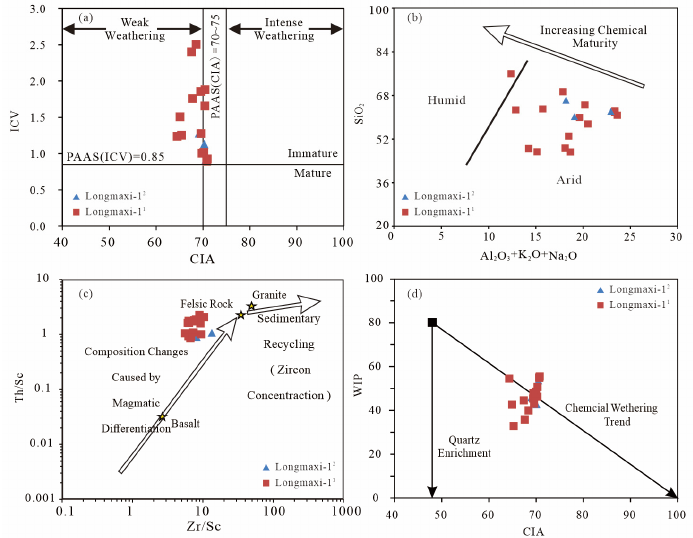
Figure 5. The discrimination diagram of palaeoweathering intensity and maturity in Longmaxi-1 black shales. ( a ) CIA-ICV [45]; ( b ) (Al 2 O 3 +K 2 O+Na 2 O)-SiO 2 [60]; ( c ) Zr/Sc-Th/Sc [48]; ( d ) CIA-WIP [43].